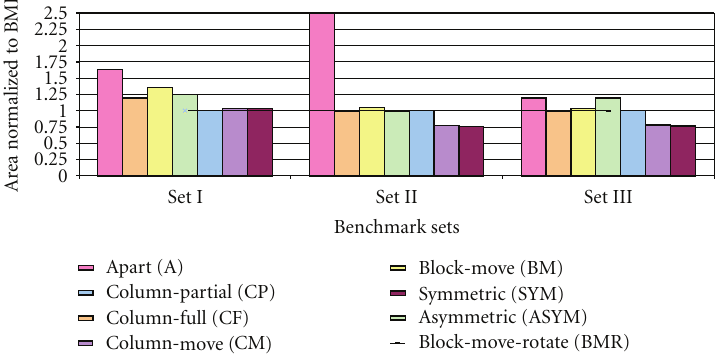
Figure 16: Generalized area results of mesh- and tree-based